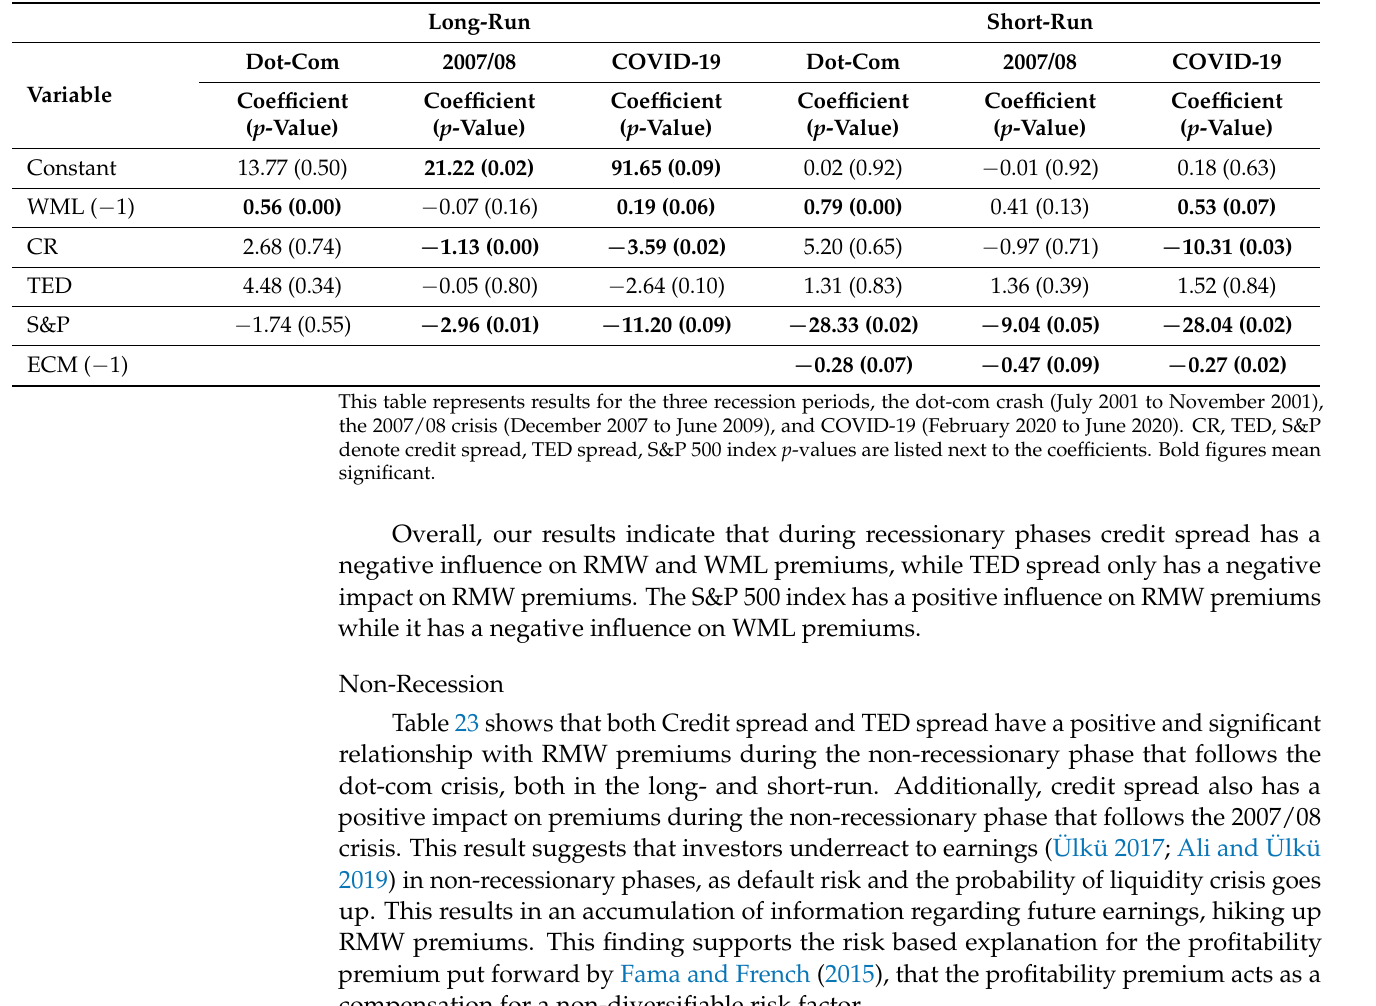
Table 22. Long-run ARDL model and short-run error correction model for WML (Recession).